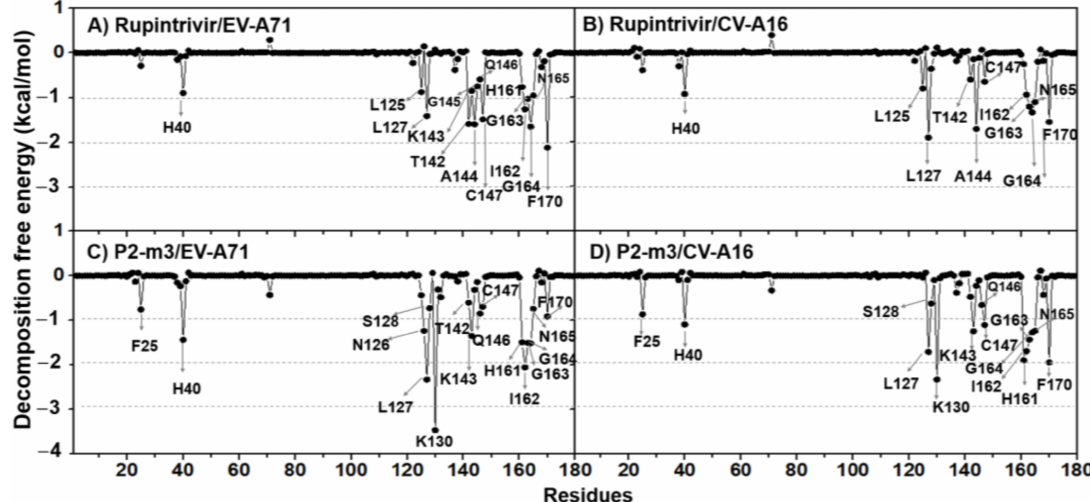
Figure 6. MM-PBSA per-residue decomposition free energy of the rupintrivir and its analog P2-m3 in complex with EV-A71 and CV-A16